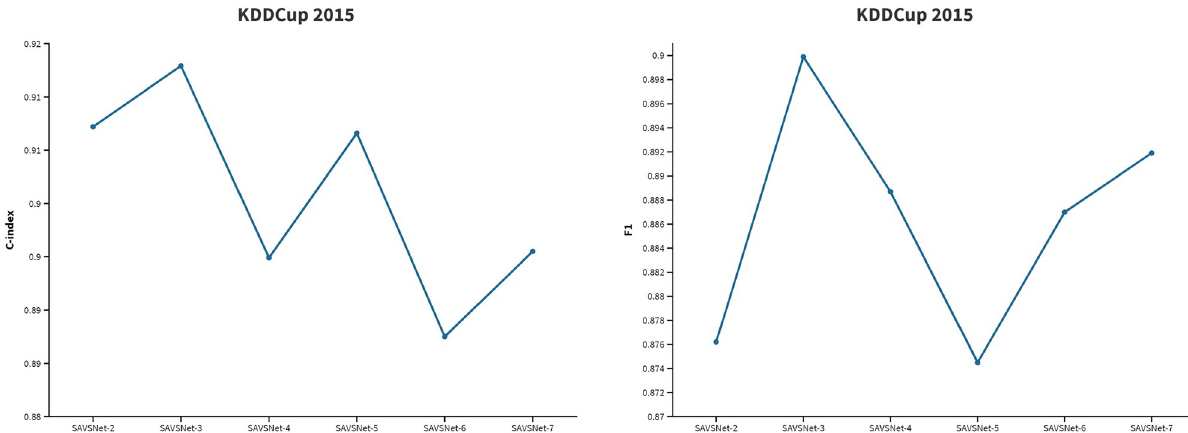
Fig 4. The results of C-index and F1 on KDDCup 2015 with different convolution kernel size.